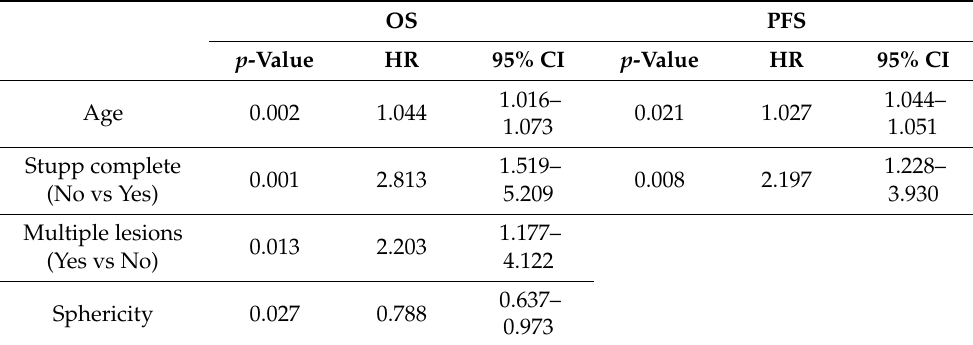
Table 5. Multivariate analysis of clinical and 18 F-fluorocholine PET/CT radiomics variables with OS and DFS (*).